Question: What style of plot is this figure drawn as?
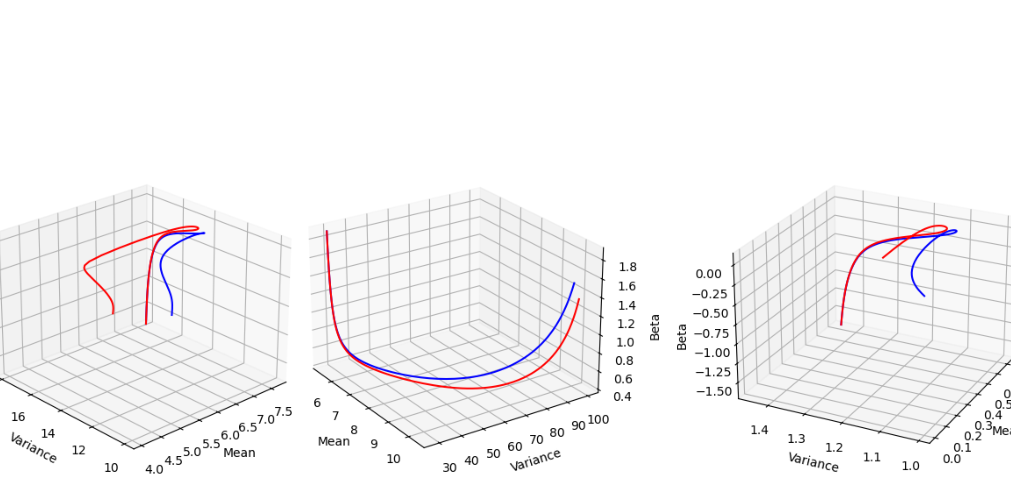
Answer: line